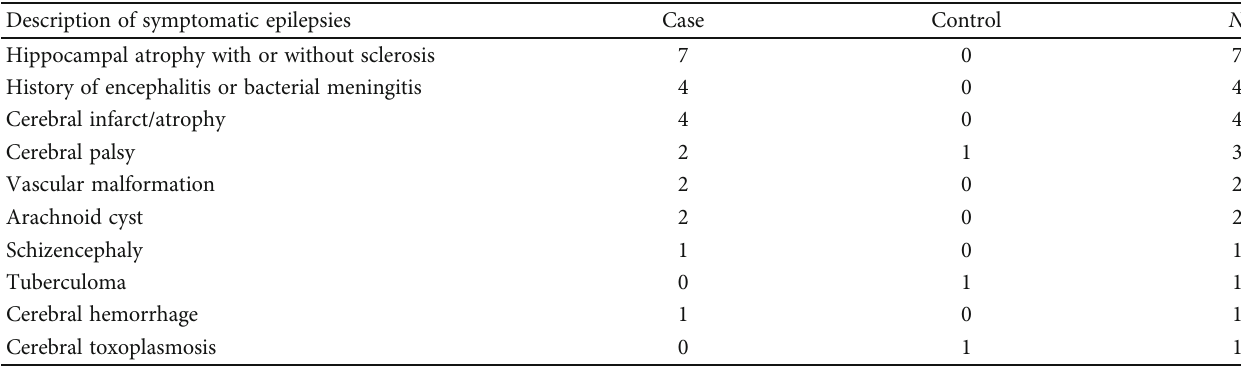
Table 2: Description of 26 patients with symptomatic